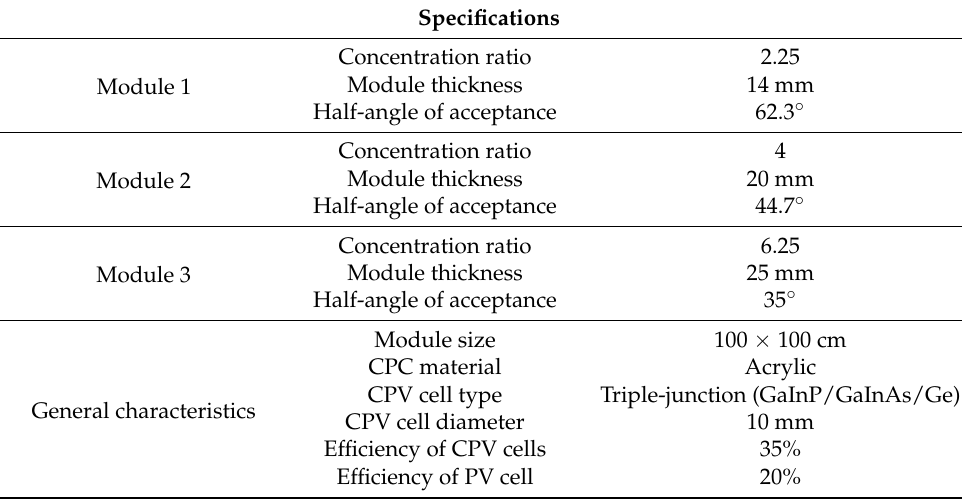
Figure 6. Simulation results: the optical efficiencies as a function of incidence angles for different